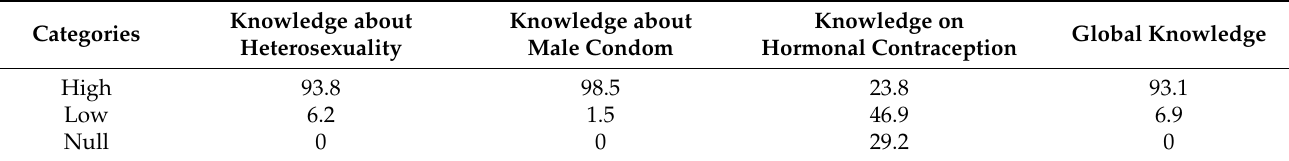
Table 3. Level of knowledge about heterosexuality and contraception.